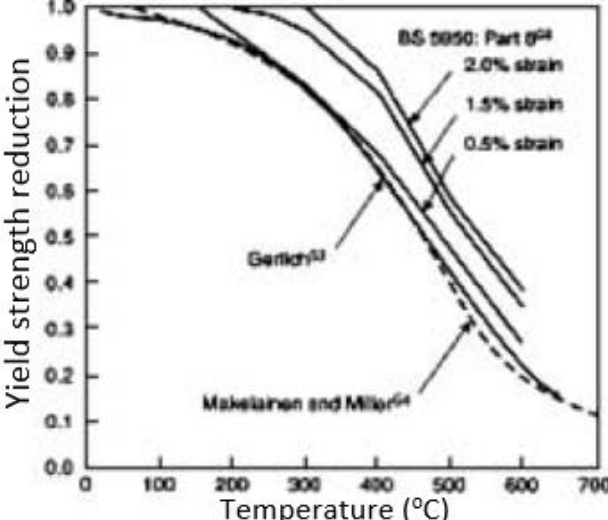
Figure 3. Decrease of the yield strength of cold-deformed steel at raised temperatures [3]